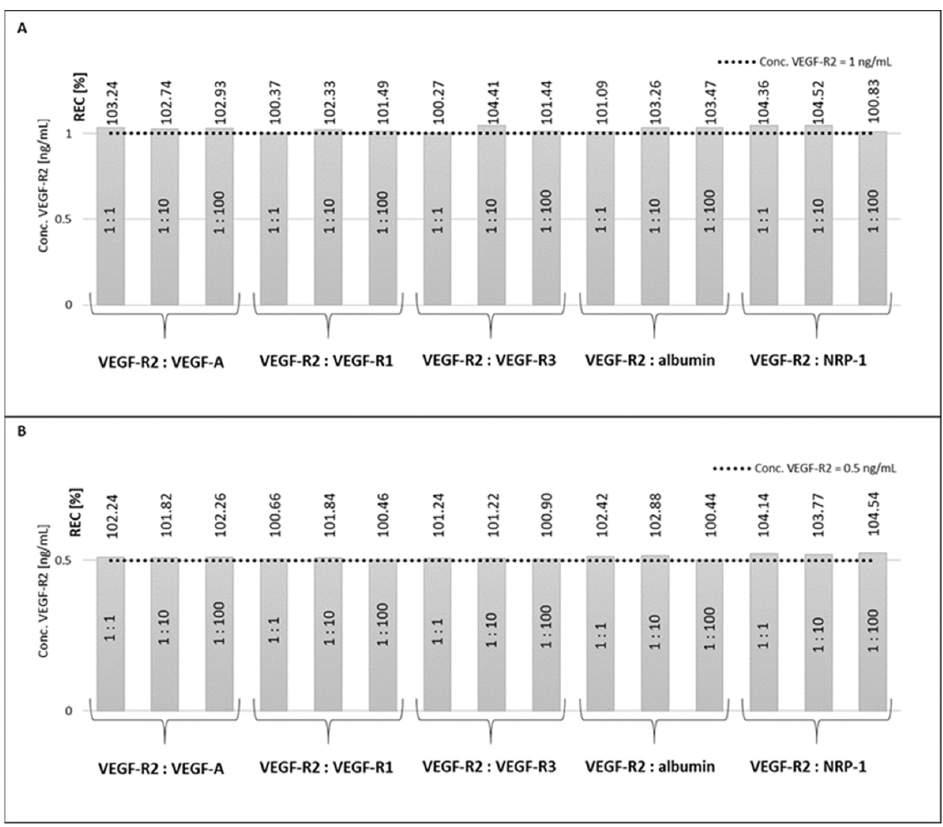
Figure 5. Selectivity of the developed methods, [VEGF-R2: interferent]. ( A ) gold chip; ( B ) bimetallic